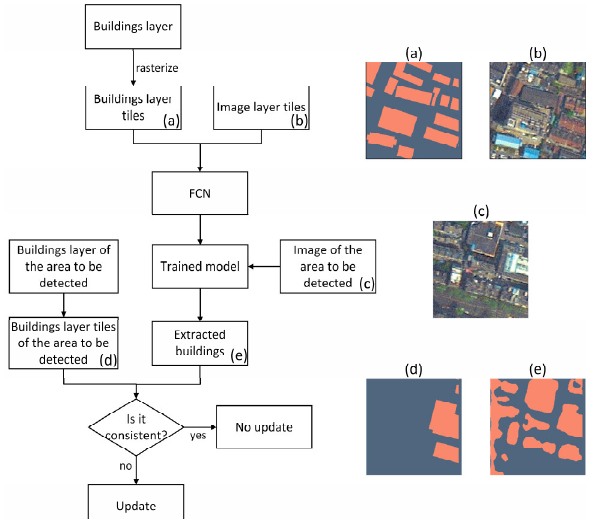
Figure 1 Operational flow about location discovery of vector data that needs to be updated.